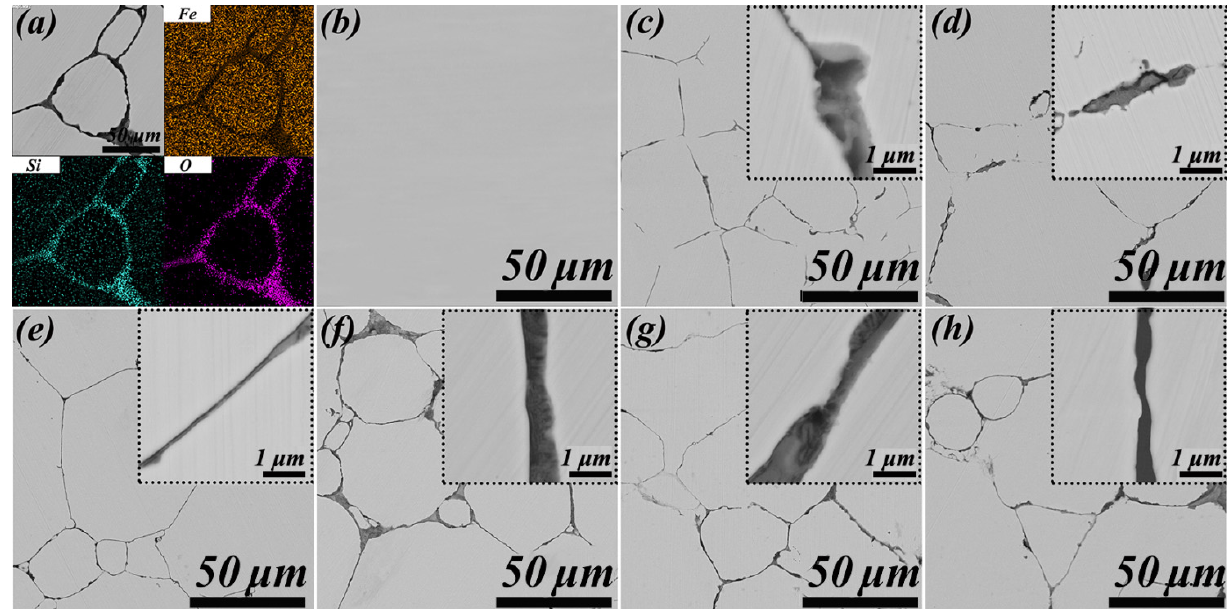
Figure 3. ( a ) EDS Fe, Si and O maps of Fe–Si/SiO 2 soft magnetic composites deposited at an Ar-dilution gas flow rate of 250 mL/min. Backscattered electron images of Fe–Si compacts ( b ) and Fe–Si/SiO 2 soft magnetic composites deposited at an Ar-dilution gas flow rate of ( c ) 125, ( d ) 150, ( e ) 200, ( f ) 250, ( g ) 300, and ( h ) 350 mL/min.